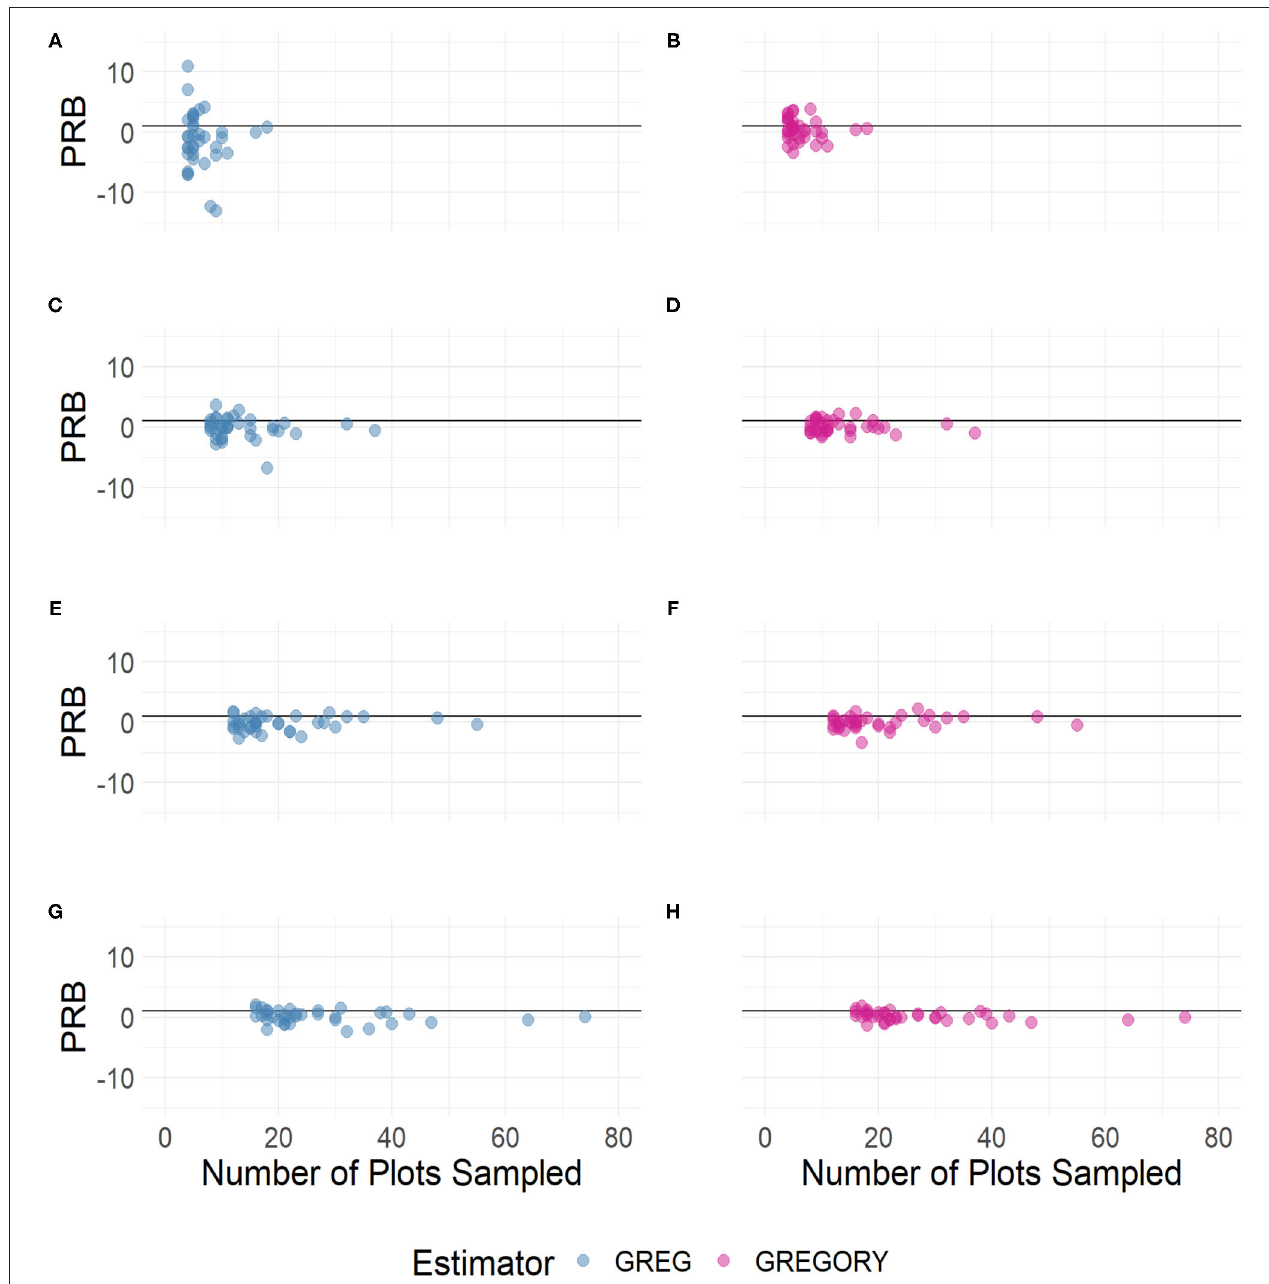
FIGURE 7 | The percent relative bias of the county estimates of average trees per acre by sample size across the following sampling intensities: (A,B) 2%, (C,D) 4%, (E,F) 6%, and (G,H)